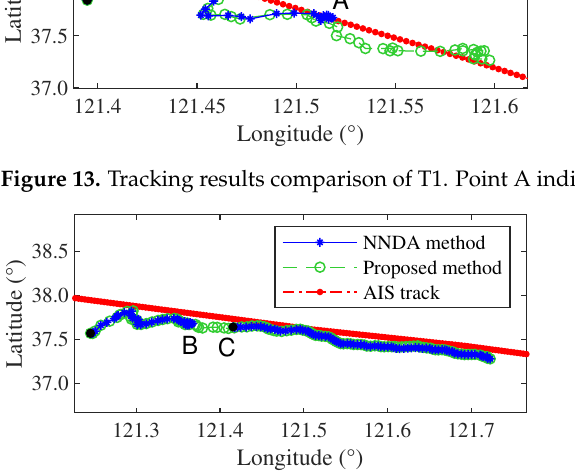
Figure 14. Tracking results comparison of T2. Point B and point C indicate the positions where the track breaks and restarts,